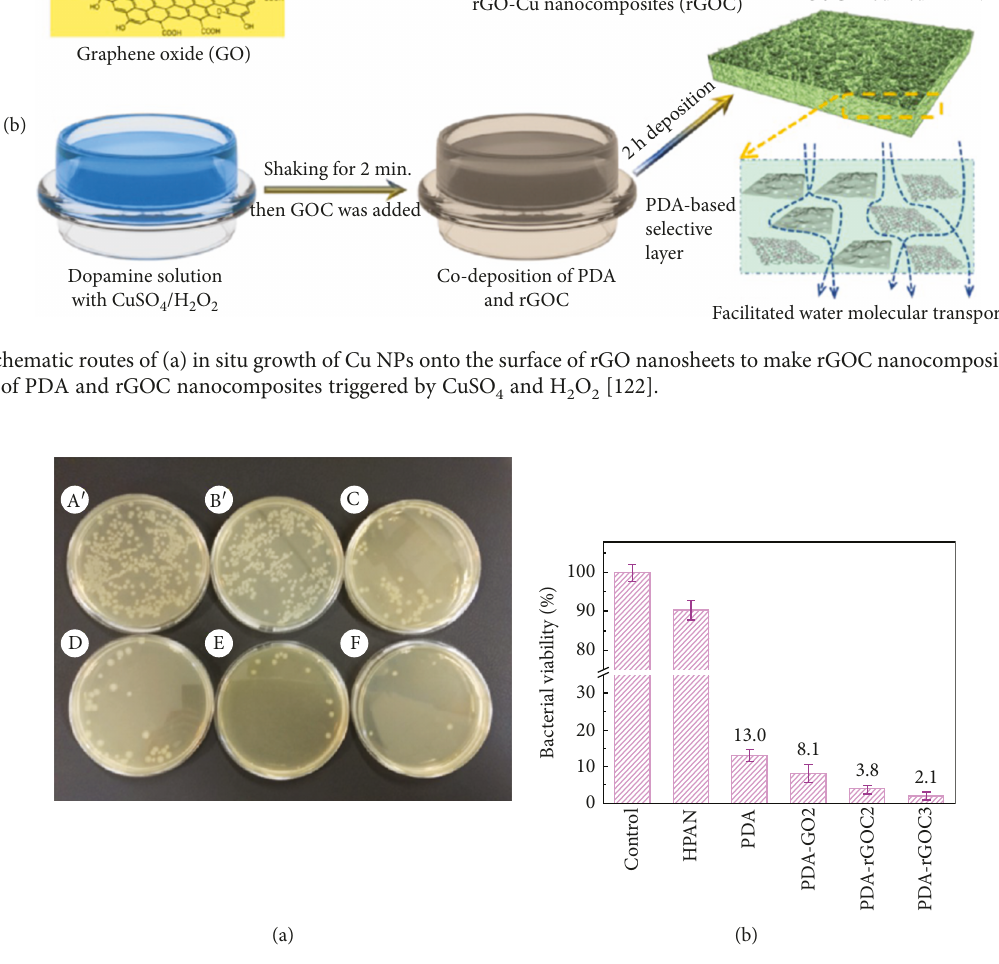
Figure 11: (a) Demonstrated antibacterial properties of the membranes based on the plate counting method: (A ′ ) control without membrane, (B ′ ) HPAN membrane, (C) PDA membrane, (D) PDA-GO2 membrane, (E) PDA-rGOC2 membrane, and (F) PDA-rGOC3 membrane. (b) Quanti fi ed antimicrobial ability of the HPAN, PDA-modi fi ed, and codeposition-modi fi ed membranes [122].